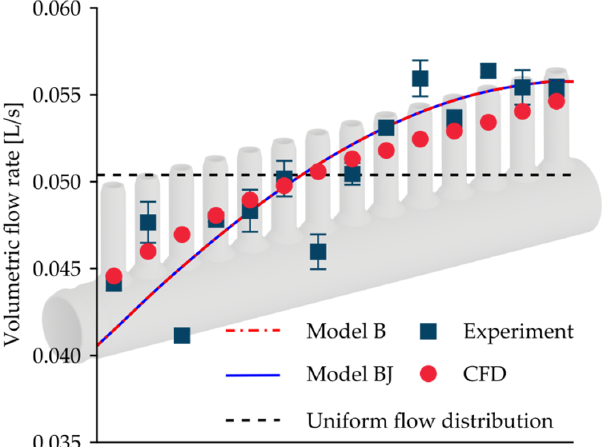
Figure 14. Volumetric flow rate distribution in the tubes of the n14 distributor. The experimental data points (average values) are plotted together with the respective observed value intervals.